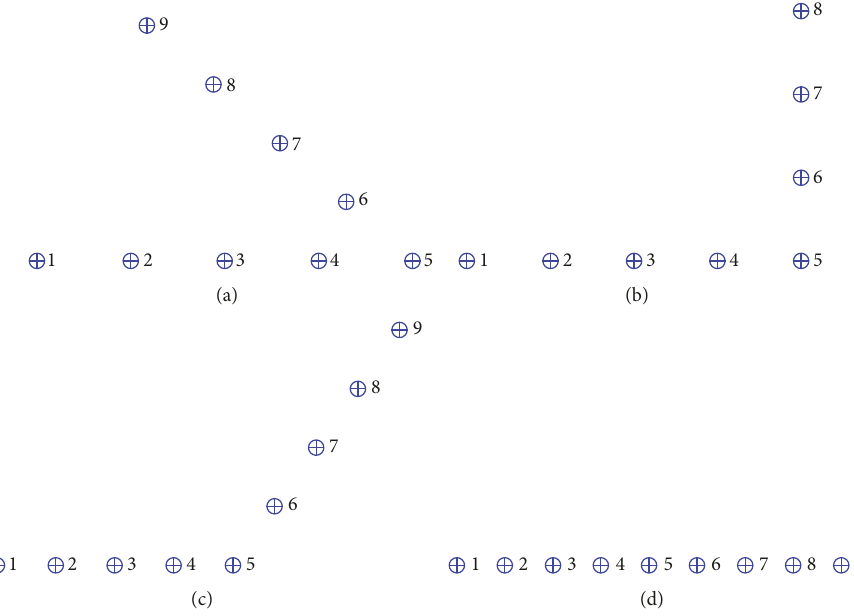
Figure 9: Schematic of 9-borehole GHEs in “ < ”-Shape (a) 𝜃 = 𝜋/4 ; (b) 𝜃 = 𝜋/2 ; (c) 𝜃 = 3𝜋/4 ; (d) 𝜃 = 𝜋 .